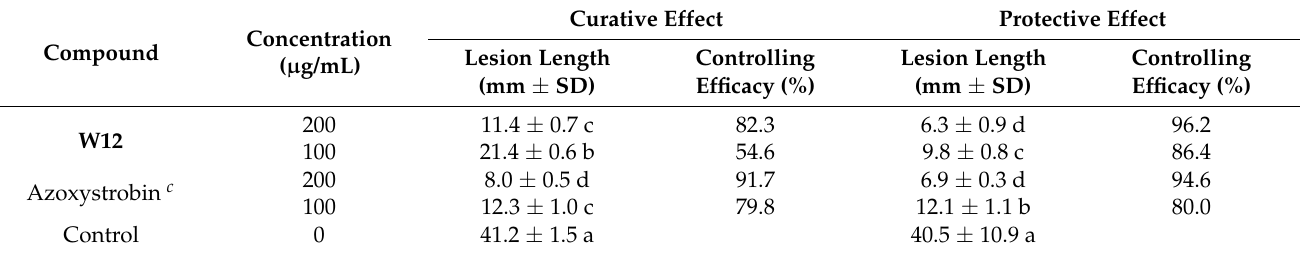
Table 4. Curative and protective activities of W12 against Phomopsis sp. in vivo a b .